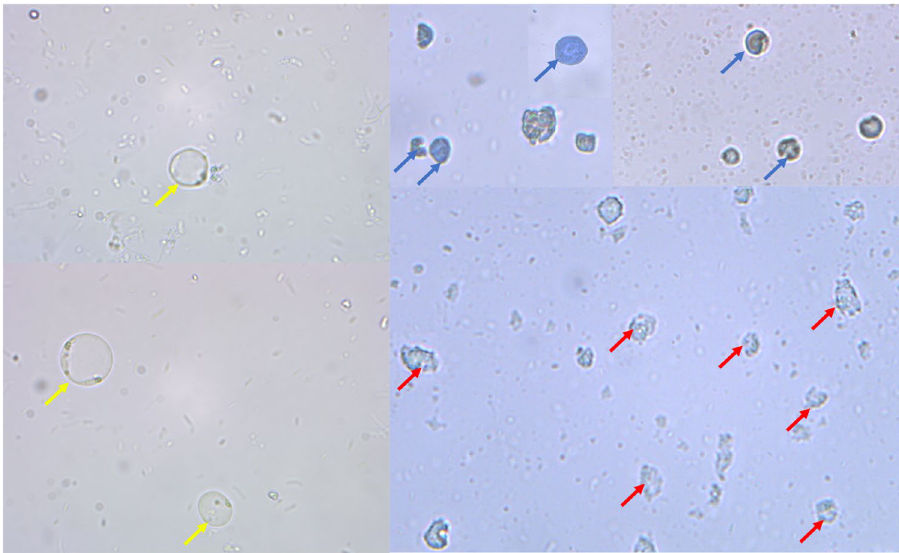
Figure 9. Trypan blue dye exclusion stained blastocystosis cysts, 400 × magnification. Live blastocystosis cysts (yellow arrows) (control group). Dead blastocystosis cysts (blue arrows). Disintegrated blastocystosis cysts (red